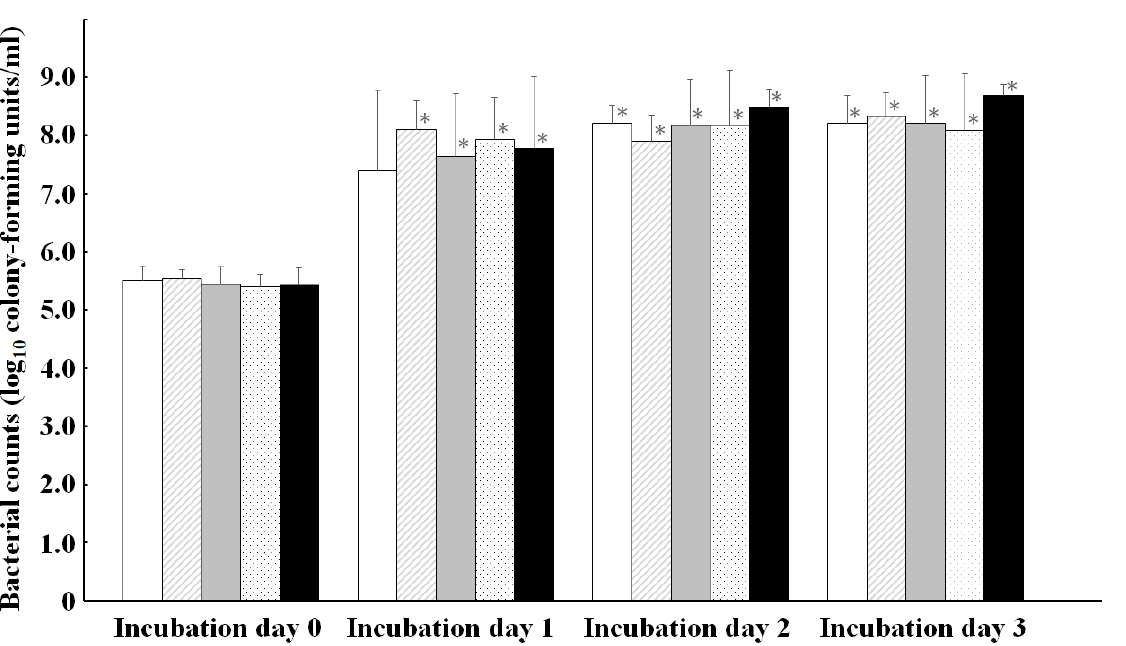
Figure 1. Correlations among Klebsiella pneumoniae isolates grouped by KP0 (white), KP1 (diagonal), KP2 (gray), KP3 (dotted), and KP4 (black) for the growths in iron-sufficient medium. * Asterisks denote significant ( p < 0.05) differences for each value of KP groups on incubation day 0. The KC1 ID , KC2 ID , and KC3 ID of KP2, KP3, and KP4 isolates were significantly ( p <